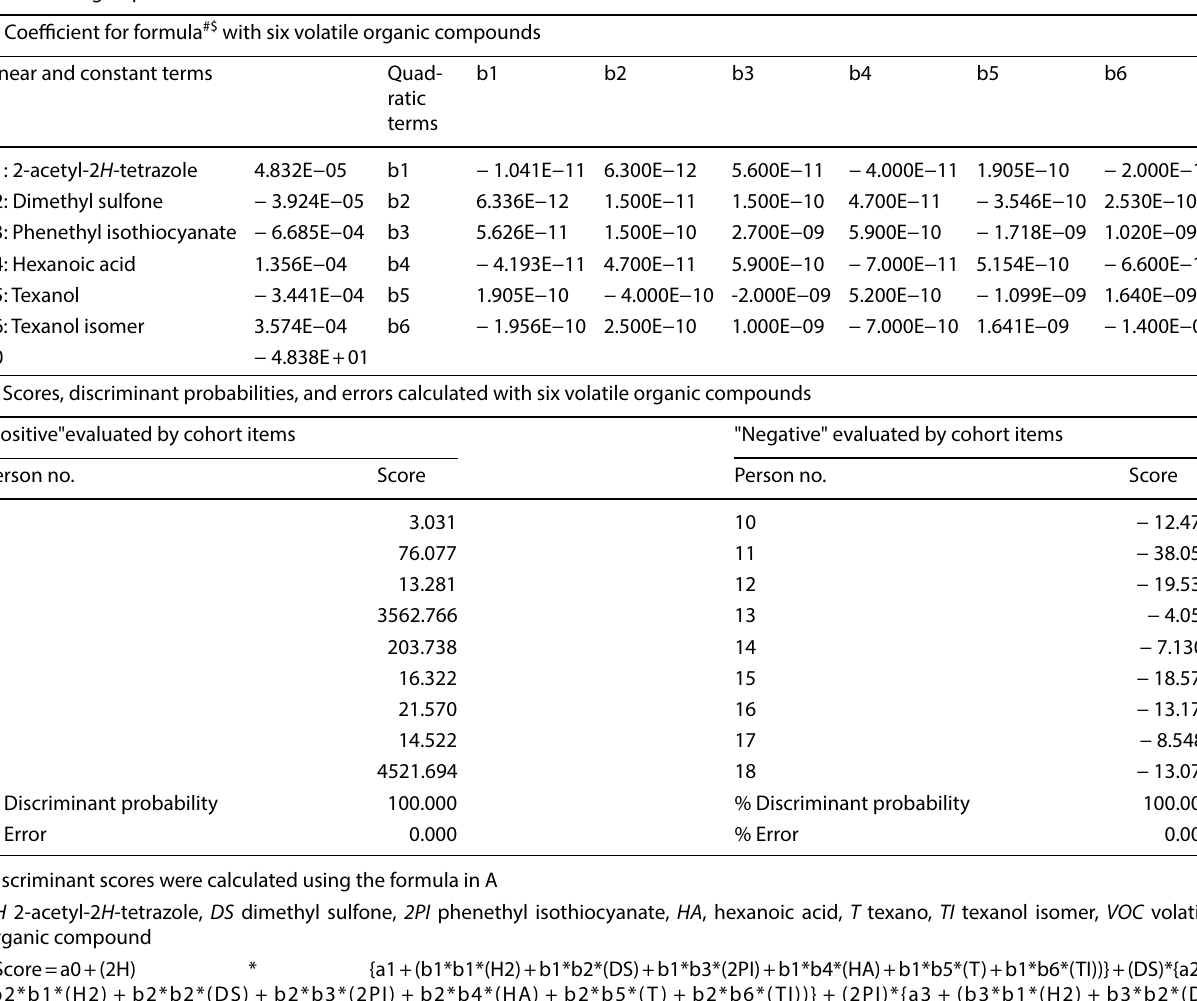
Table 3 Discriminant function analysis for determining membership of volatile organic compounds associated with major depressive disor- der and/or agoraphobia